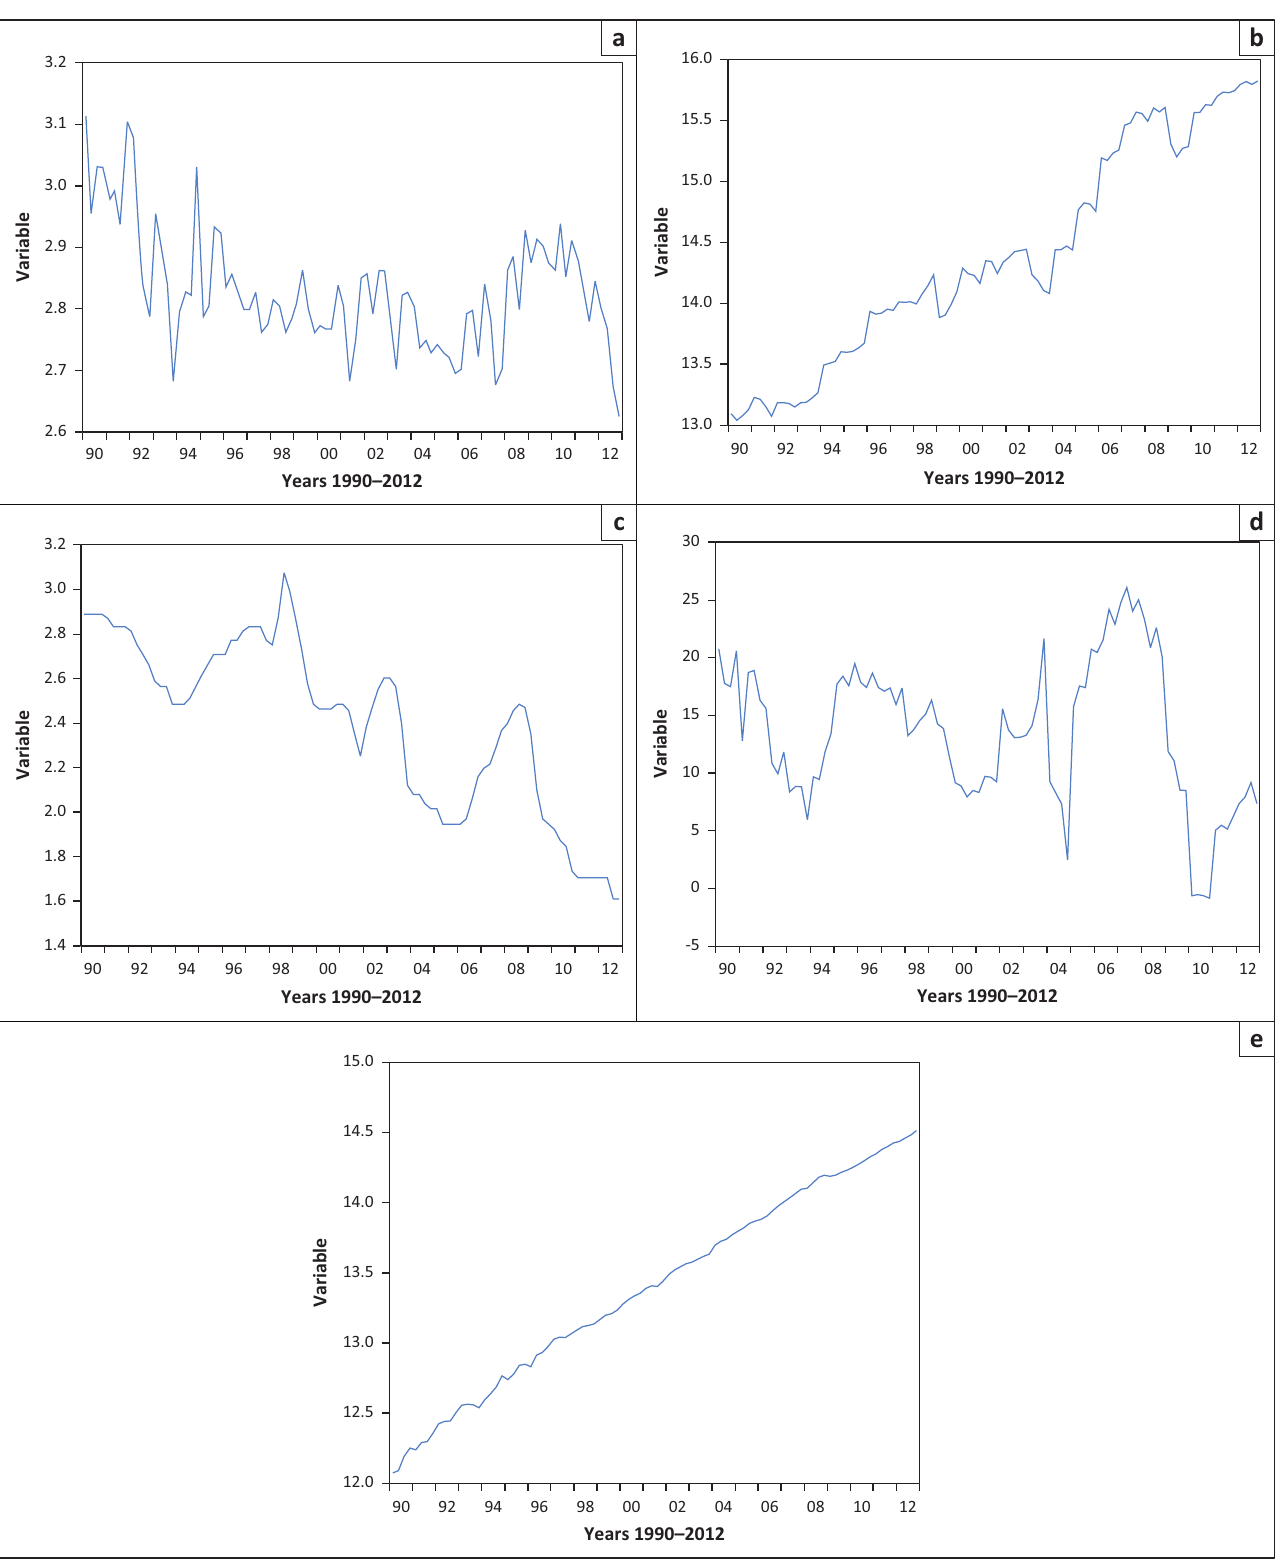
FIGURE 1: Stationarity graphs at levels. (a) Economic development, (b), road transport investment (c) government expenditure on road transport, (d) income and (e) exchange rate. be non-stationary and unit root exists. In this case, the null hypothesis is not rejected. If the t statistic is less than the critical values, time series data are stationary and unit root does not exist therefore the null hypothesis is